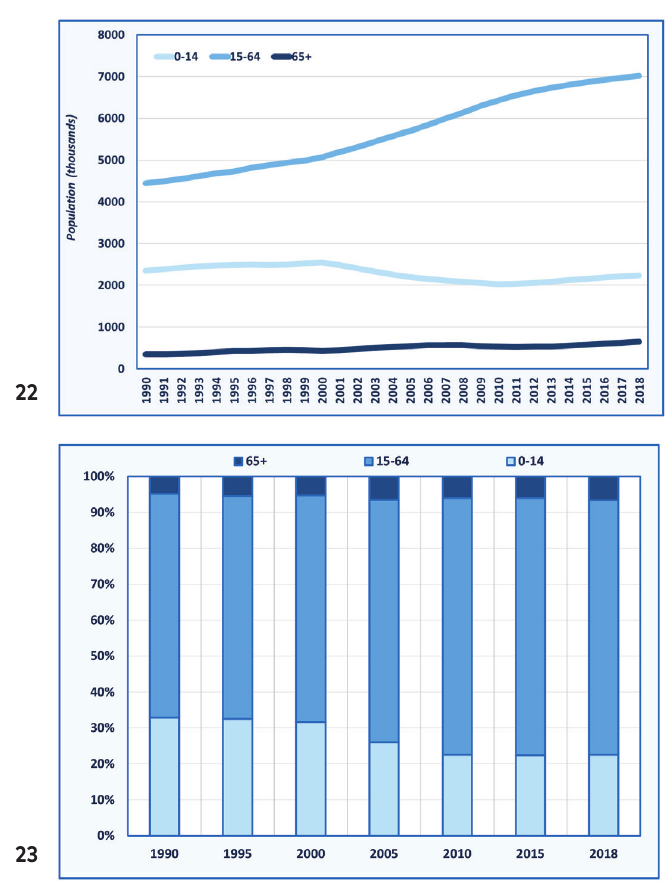
Figures 22–23. Size and share of age groups in the population of Azerbaijan (at the beginning of the year). Source: according to SSC data.